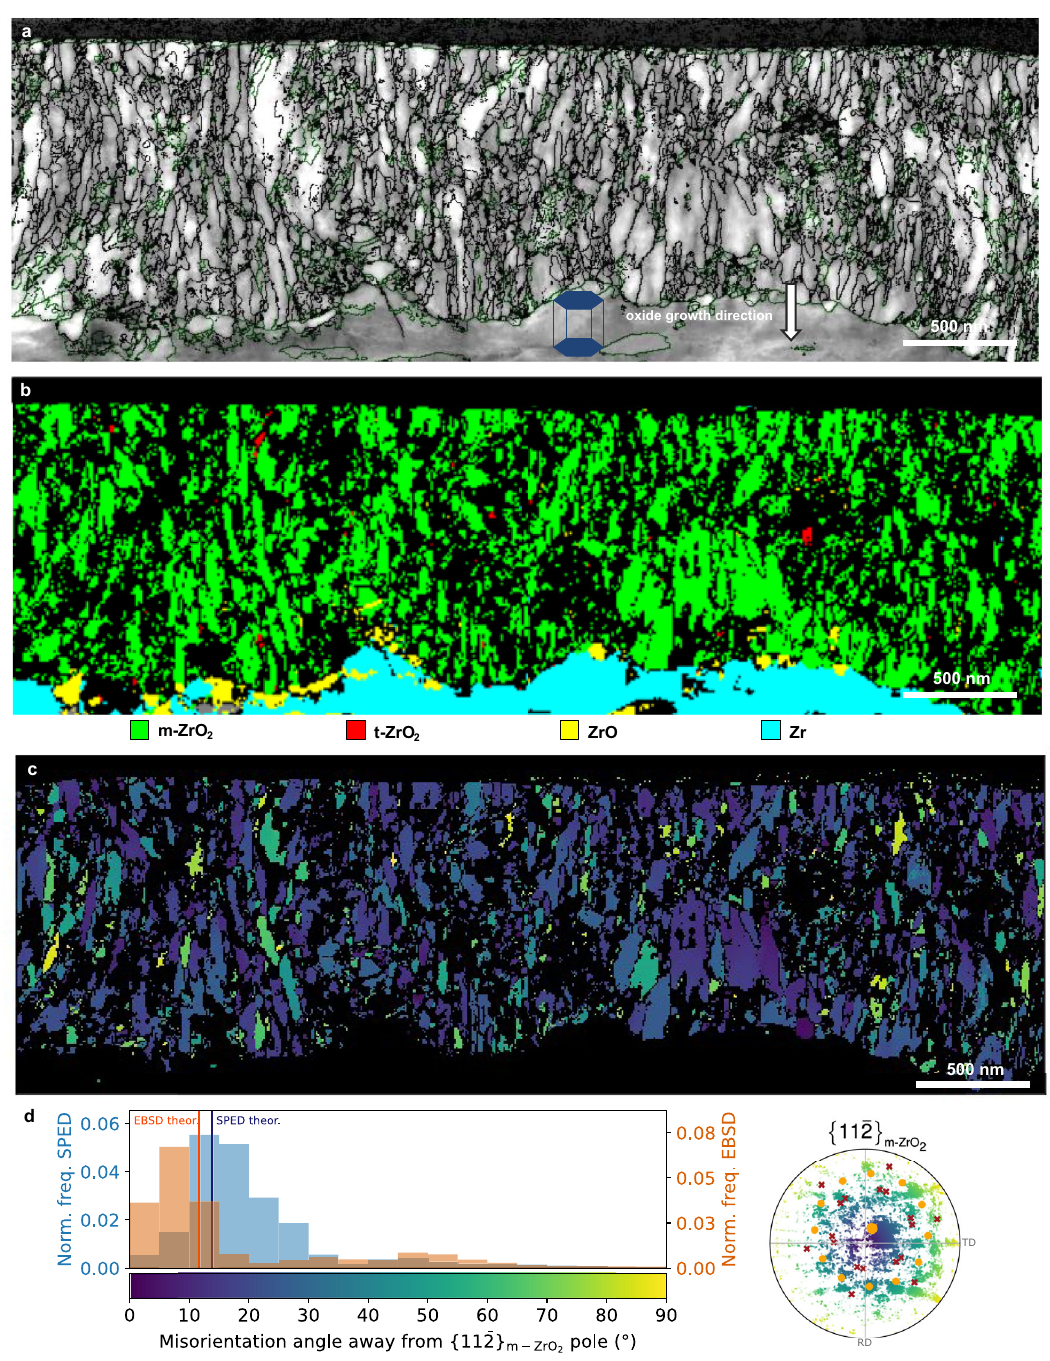
Fig. 5 | Oxide microstructure in region 2 measured using scanning electron precession diffraction (SPED) in the TEM. a Correlation index map with overlaid monoclinicoxidegrainboundariesshowninblack(interphaseboundariesshownin green).TheorientationoftheZrhcpunitcellisshown.Theoxidegrowthdirection is marked with an arrow. b Phase map with phase reliability values less than 10 shown as non-indexed points (in black) and indexed coloured according to the